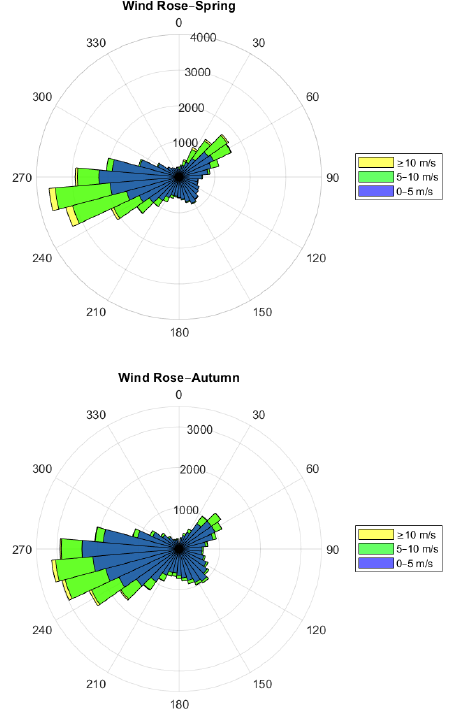
Figure 4. Wind rose diagrams for the seasons.